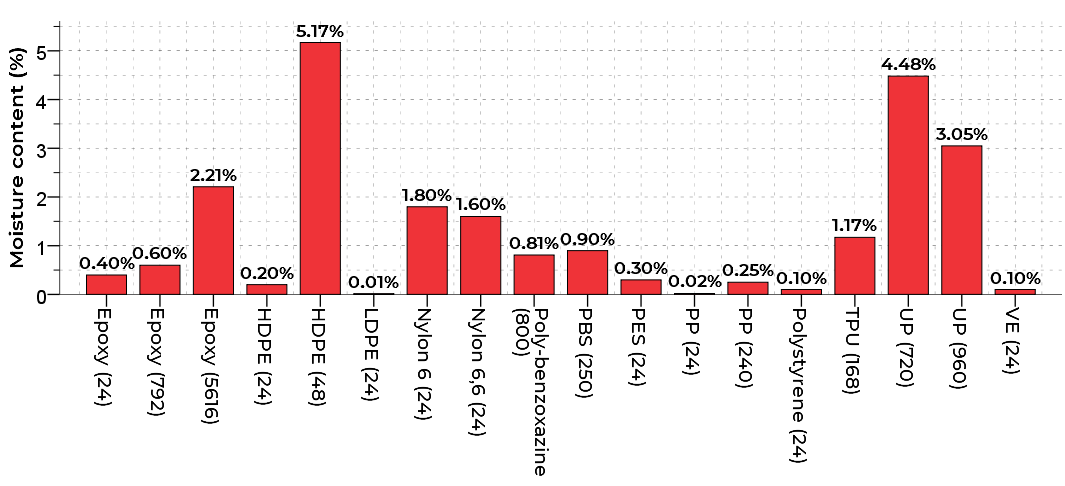
Figure 6. The equilibrium moisture content for most widely used polymers in natural composites.